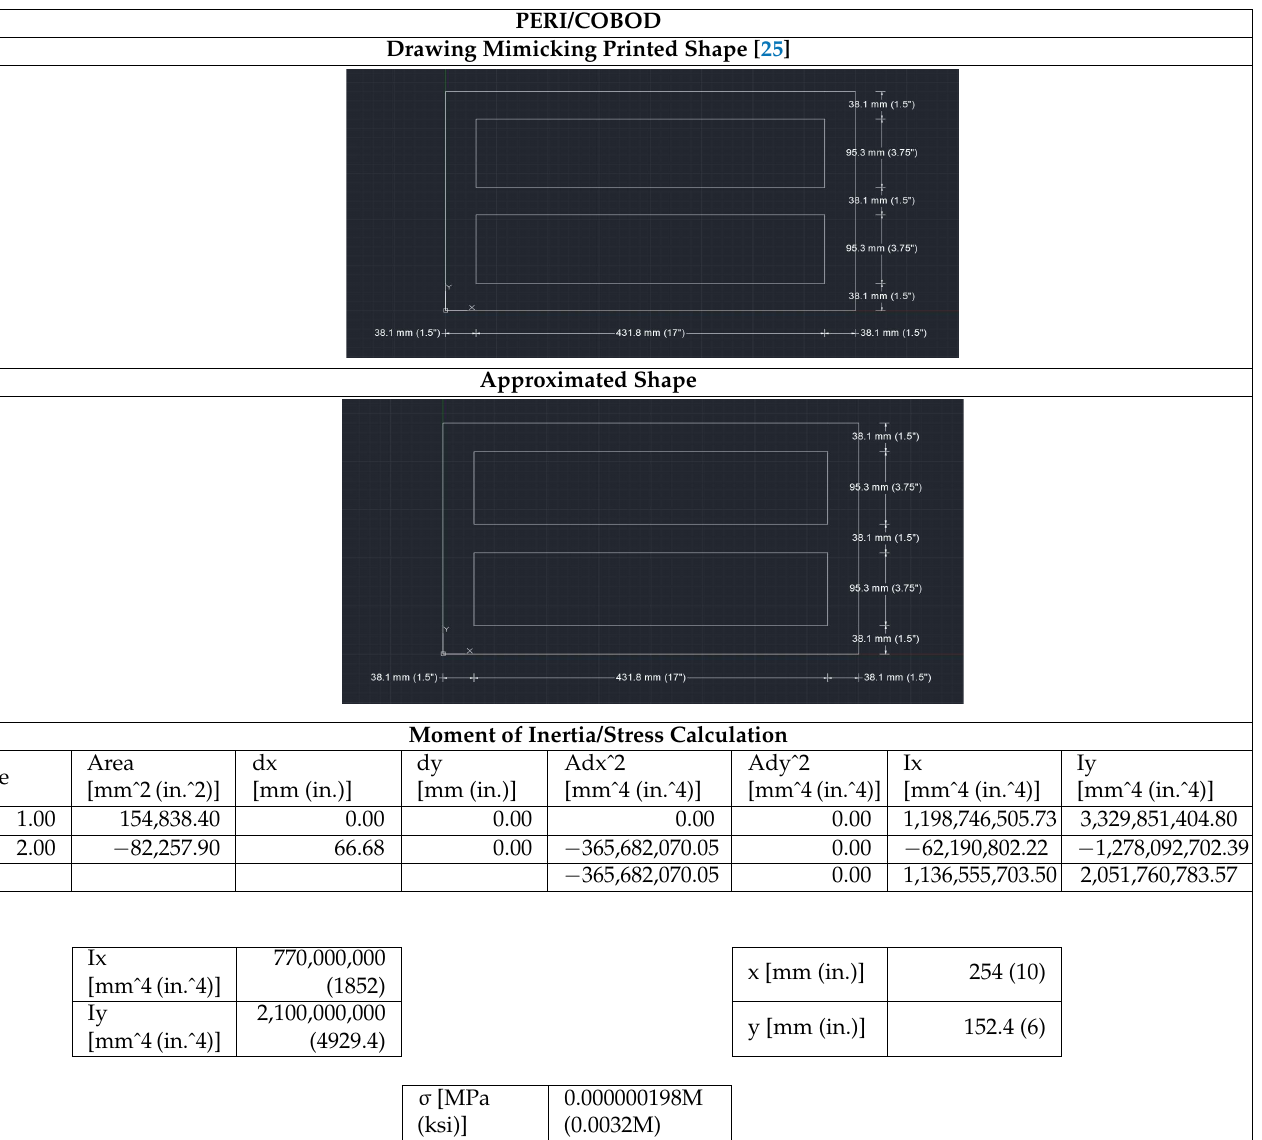
Table A2. PERI/COBOD wall calculations.